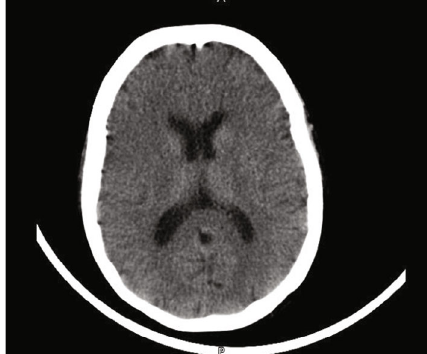
Figure 2: Chest X-ray showing small consolidations in both lower lobes with linear atelectatic